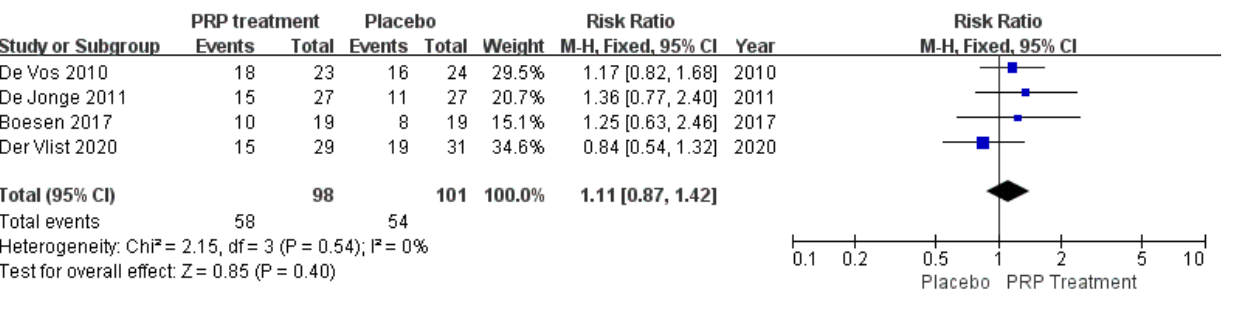
Figure 9. Forest plot of patient return to exercise